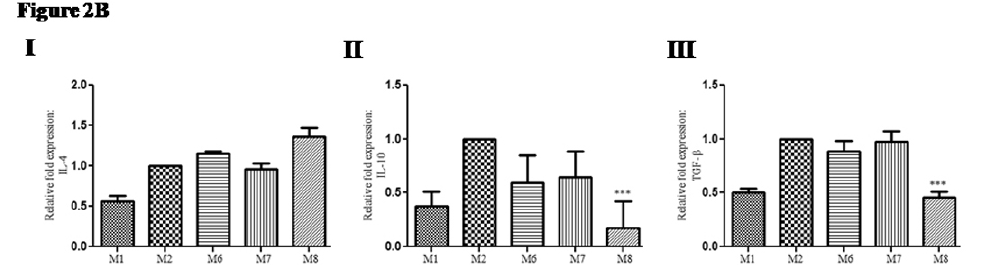
Fig. 2B. Change in anti-inflammatory gene expression in infected mice upon therapeutic use of recombinant cytokine(s): Marginal change in relative fold expression of anti-inflammatory cytokines gene expression was observed. (I) Gene expression of IL-4 (II) Gene expression of IL-10 (III) Gene expression of TGF- β